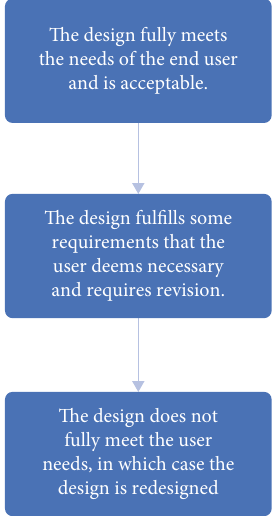
Figure 1: Possible outcomes of proposed